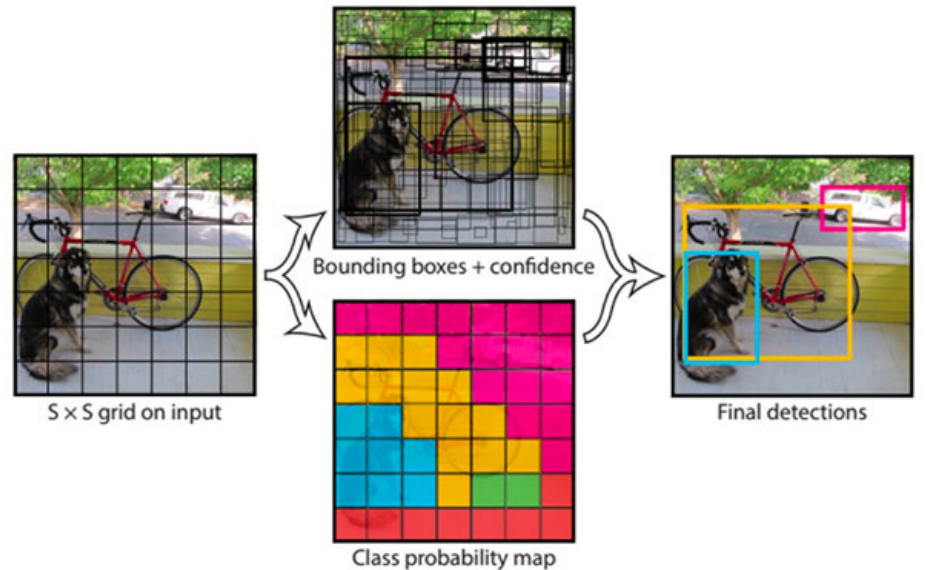
Figure 9. The explained architecture of YOLO [24]. YOLO sees the complete image at once and segments an image into S × S grids. Each cell predicts bounding boxes and a confidence score for every bounding box. The cell in which object is present at the center is liable to detect the object. Reprinted from [24].